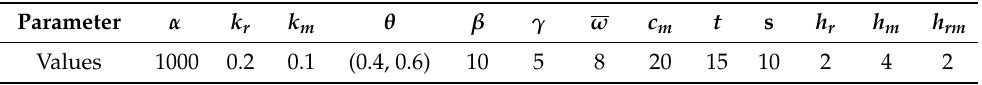
Parameter Table 3. Simulation parameters are assigned in the numerical study. Parameter